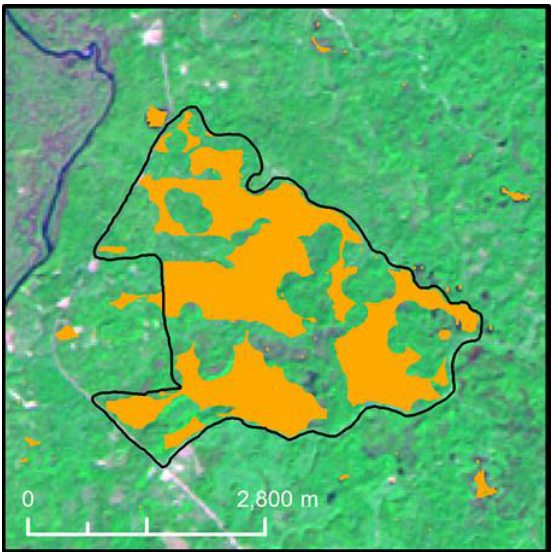
Figure 3. Enlarged view showing more precise delineation of the fire burned area and unburned islands within the perimeter.